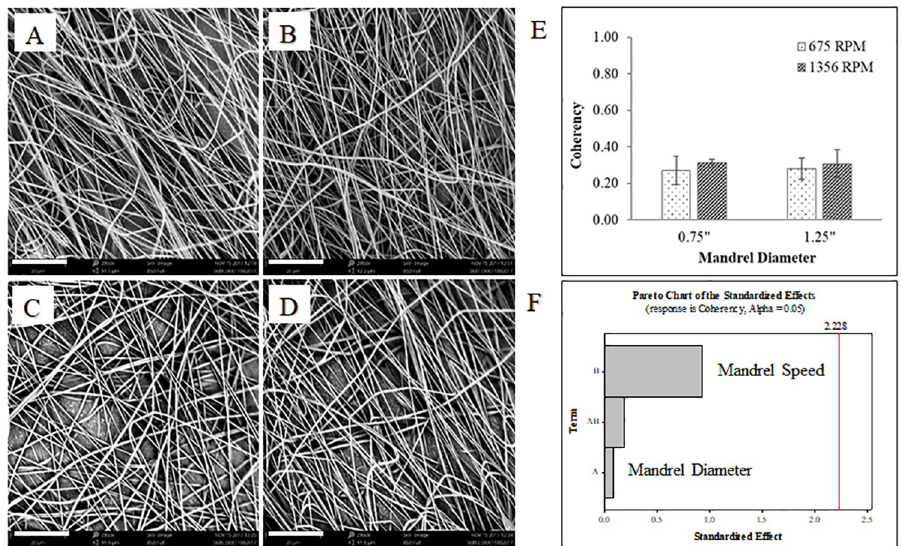
Fig 2. PNIPAM nanofibers as a function of mandrel diameter and mandrel speed. (A) 0.75” (19mm) mandrel diameter, 675 RPM. (B) 0.75”, 1356 RPM. (C) 1.25” (31.8mm), 675 RPM. (D) 1.25”, 1356 RPM. Scale bar (lower left of each image) is 20 μ m. Alignment is not affected by mandrel diameter or mandrel speed, as shown in (E) as coherency values and (F) in the analysis of the factorial